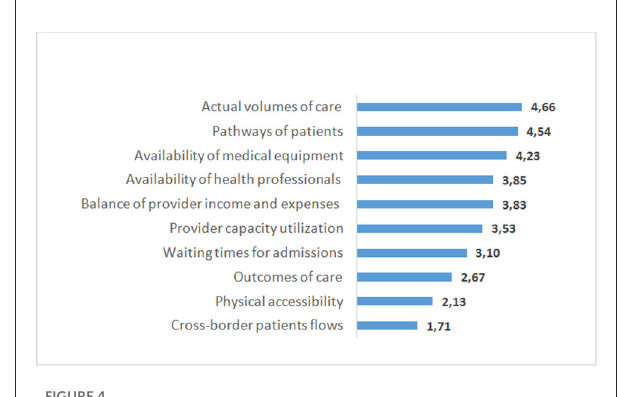
FIGURE4 Average values of the criteria used by 86 regional MHI funds in Russia for the care volume allocation among medical care